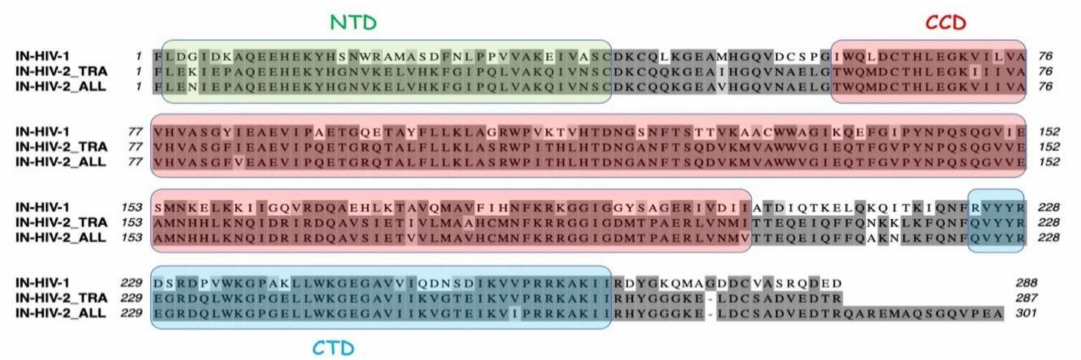
Figure 3. Sequence alignment of integrases from HIV-1 and HIV-2. Integrase from HIV-1 of pNL4-3 (IN_HIV-1) and two integrase species from two HIV-2 isolates (IN-HIV-2_TRA and IN-HIV-2_ALL) are aligned. Residues conserved in at least two sequences are outlined in dark grey, similar residues are in light grey. The three structural domains (NTD, CCD, and CTD) are indicated according to Figure 1A. Because HIV-2 also uses the host tRNA 3Lys as a primer for initiation of the reverse transcription process, it is probable that HIV-2 also uses mLysRS to form the tRNA 3Lys packaging complex. The CTD of integrase from HIV-1 is responsible for the interaction with mLysRS (Figure 1), and it is noticeable that the CTD domains of integrases from HIV-1 and HIV-2 are the most conserved regions. The two forms of integrase from two HIV-2 isolates were expressed with a C-terminal His-tag, IN from HIV-2_TRA and from HIV-2_ALL. The two integrases from HIV-2 interacted with mLysRS with binding a ffi nities of 3.5 ± 0.6 nM and 2.4 ± 0.3 nM, respectively, for IN from HIV-2_TRA and IN from HIV-2_ALL, which is similar to the value of 2.6 ± 0.3 nM observed for IN of HIV-1 (Figure 4). These data indicate that the binding site of IN for mLysRS are conserved between HIV-1 and